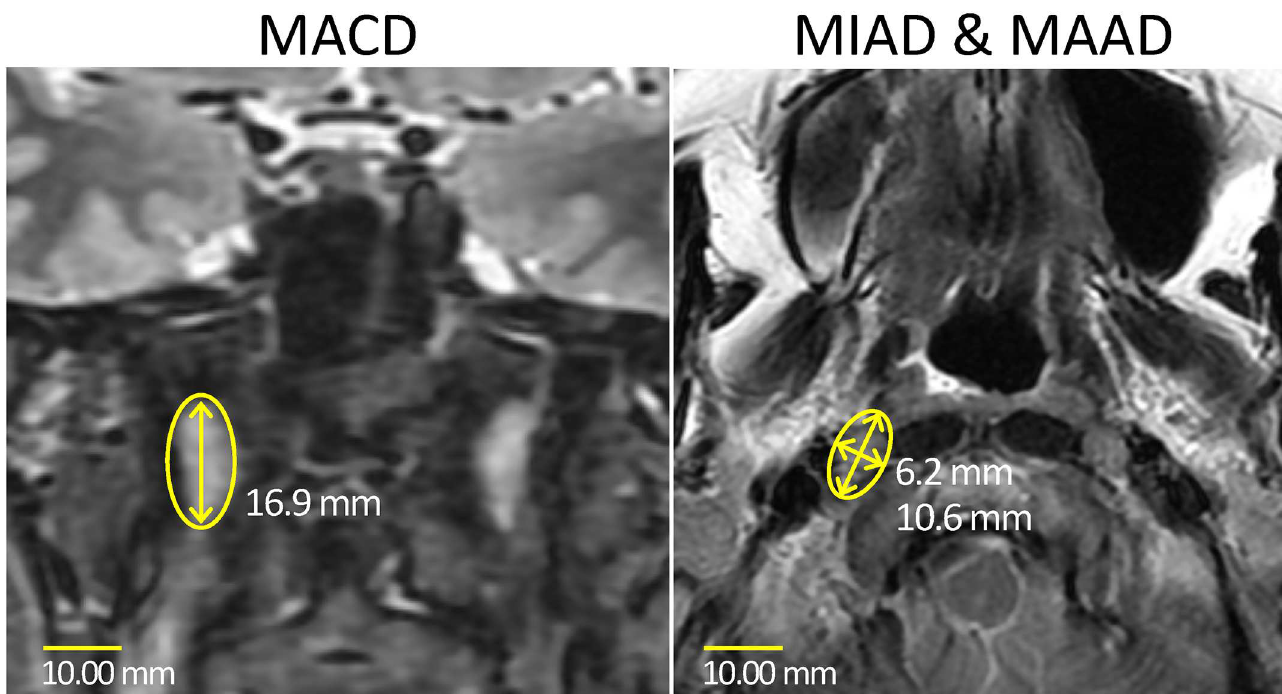
Fig 1. Measuring the three diameters of a right lateral retropharyngeal node. This image was obtained from a 48-year-old NPC woman with a lateral retropharyngeal lymph node (yellow circled) on a T2-weighted MRI. (a) In axial plane, the MAAD (10.6 mm) shouldbe measured first, and the MIAD (6.2 mm) should then be measured in the perpendicular direction. (b) Coronal plane of image showingthat the MACD (16.9 mm) of the node can be measured using an electroniccaliper easily. NPC, nasopharyngealcancer; MIAD, minimal axial diameter; MAAD, maximal axial diameter; MACD, maximal